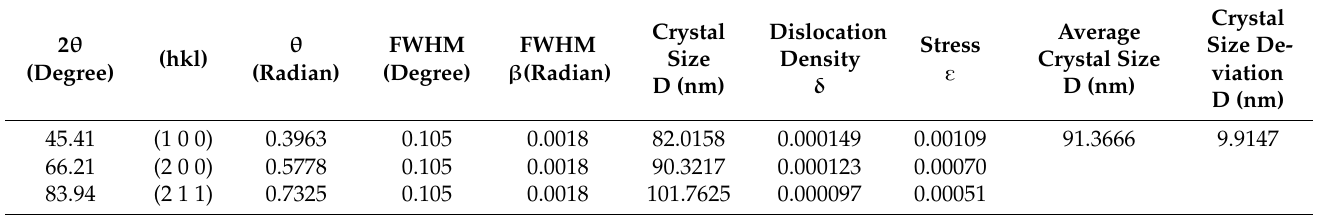
Table 4. Calculated crystallographic parameters of bare Fe 3 O 4 NPs with data obtained from XRD analysis using the Scherrer equation.